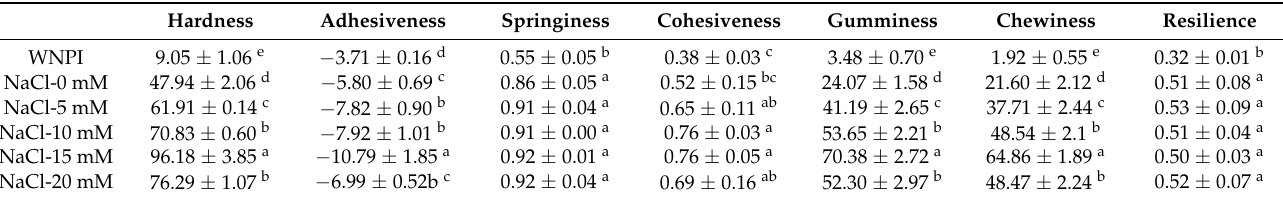
Table 1. Textural properties of WNPI-KC composite gel samples with NaCl.